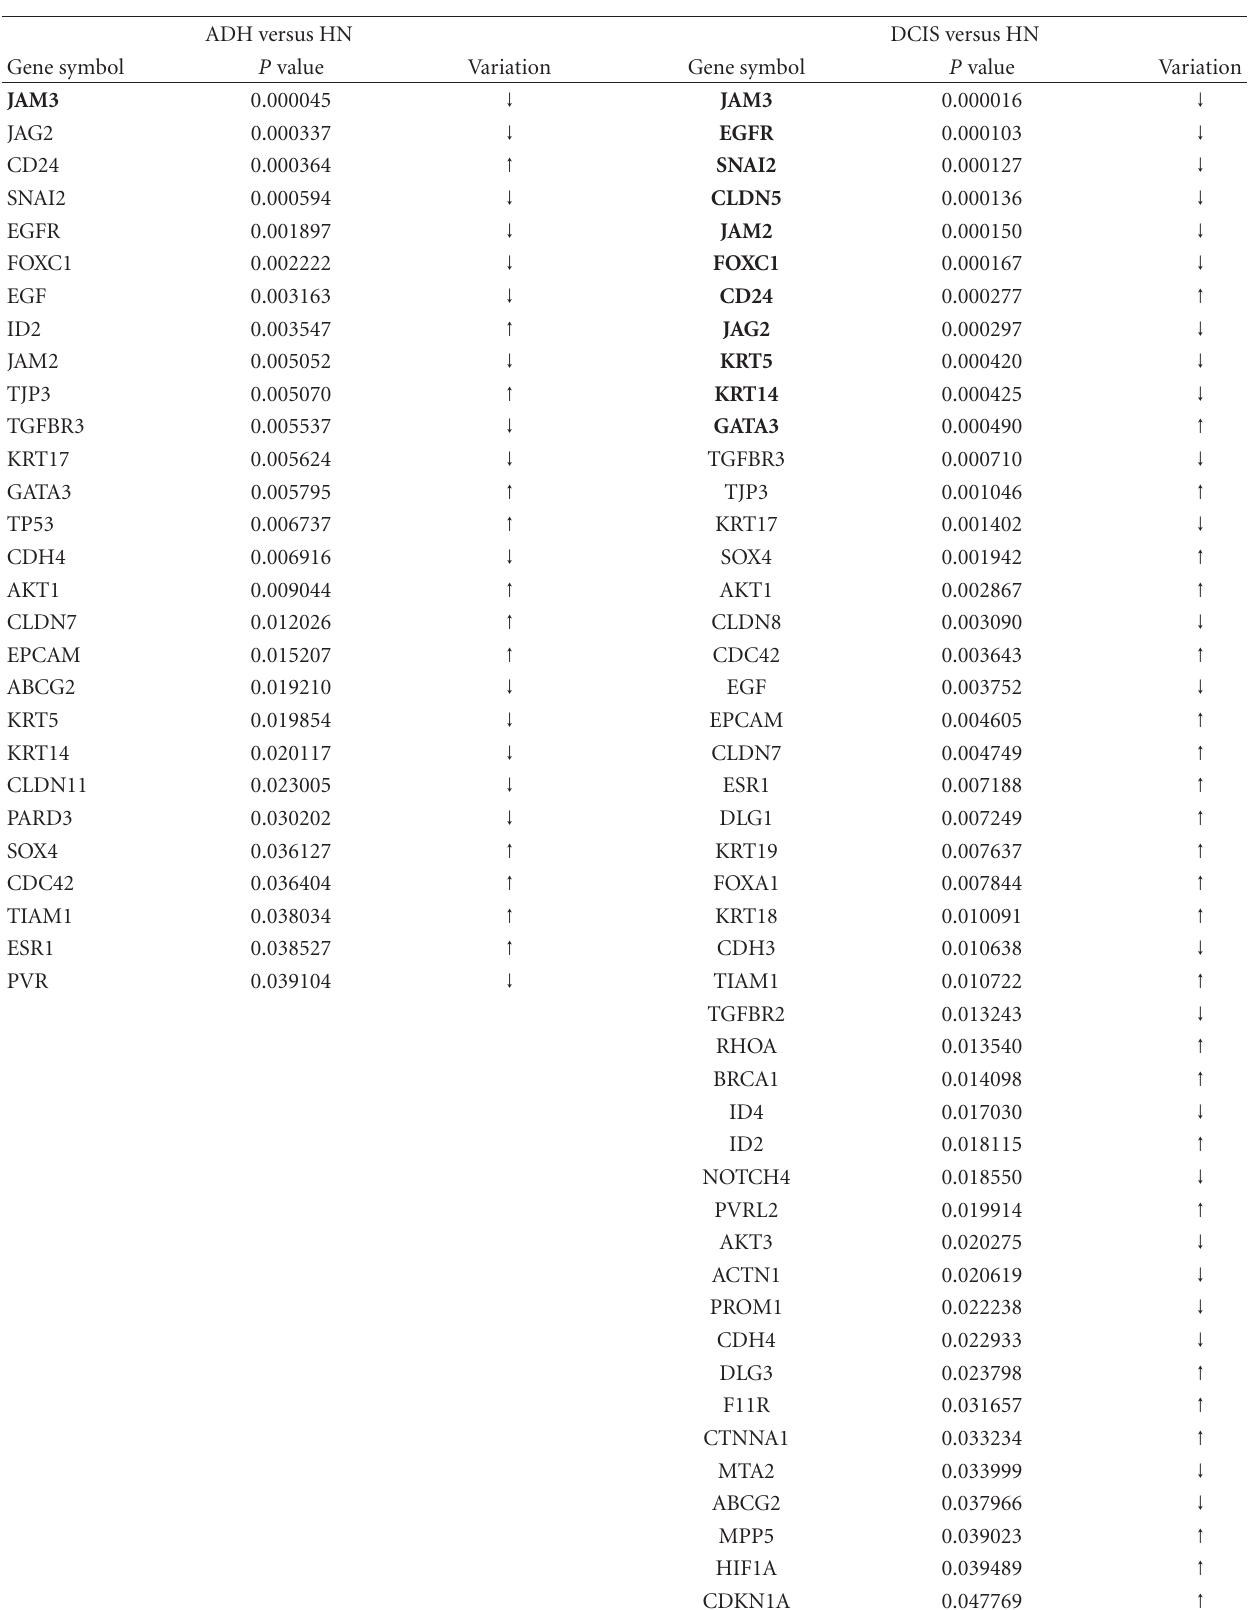
Table 1: Di ff erentially expressed genes between ADH or DCIS and histologically normal (HN) tissue (ordered according to P value). ADH versus HN DCIS versus HN Gene